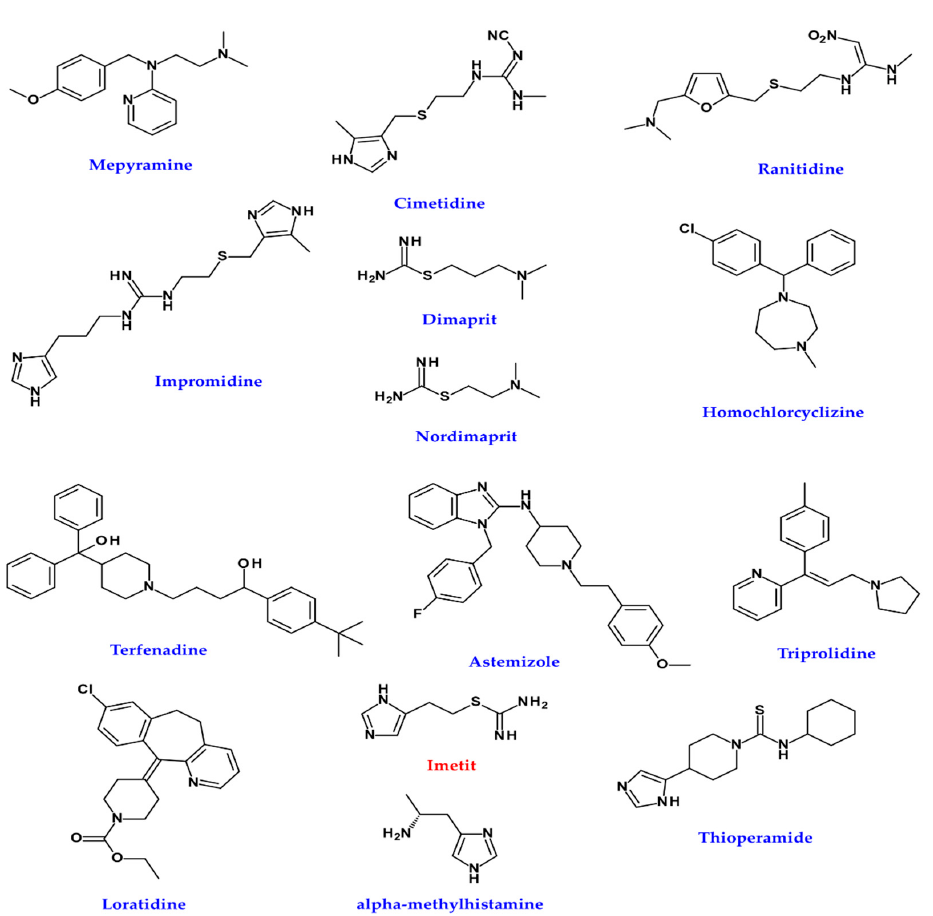
Figure 6. Chemical structures of agonist (red), and antagonist (blue) of histamine.